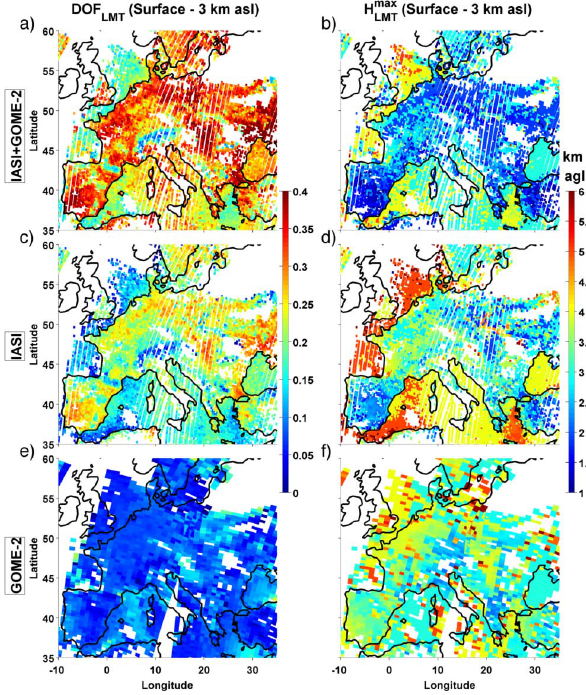
Fig. 5. Degrees of freedom DOF LT (left) and heights of maximum AVK (kma.g.l.) H max (right) in the lower troposphere (LT, from the LT surface up to 6km a.s.l.) for ( a and b ) IASI+GOME-2, ( c and d ) IASI only and ( e and f ) GOME-2 only ozone retrievals over Europe on 19 August 2009.